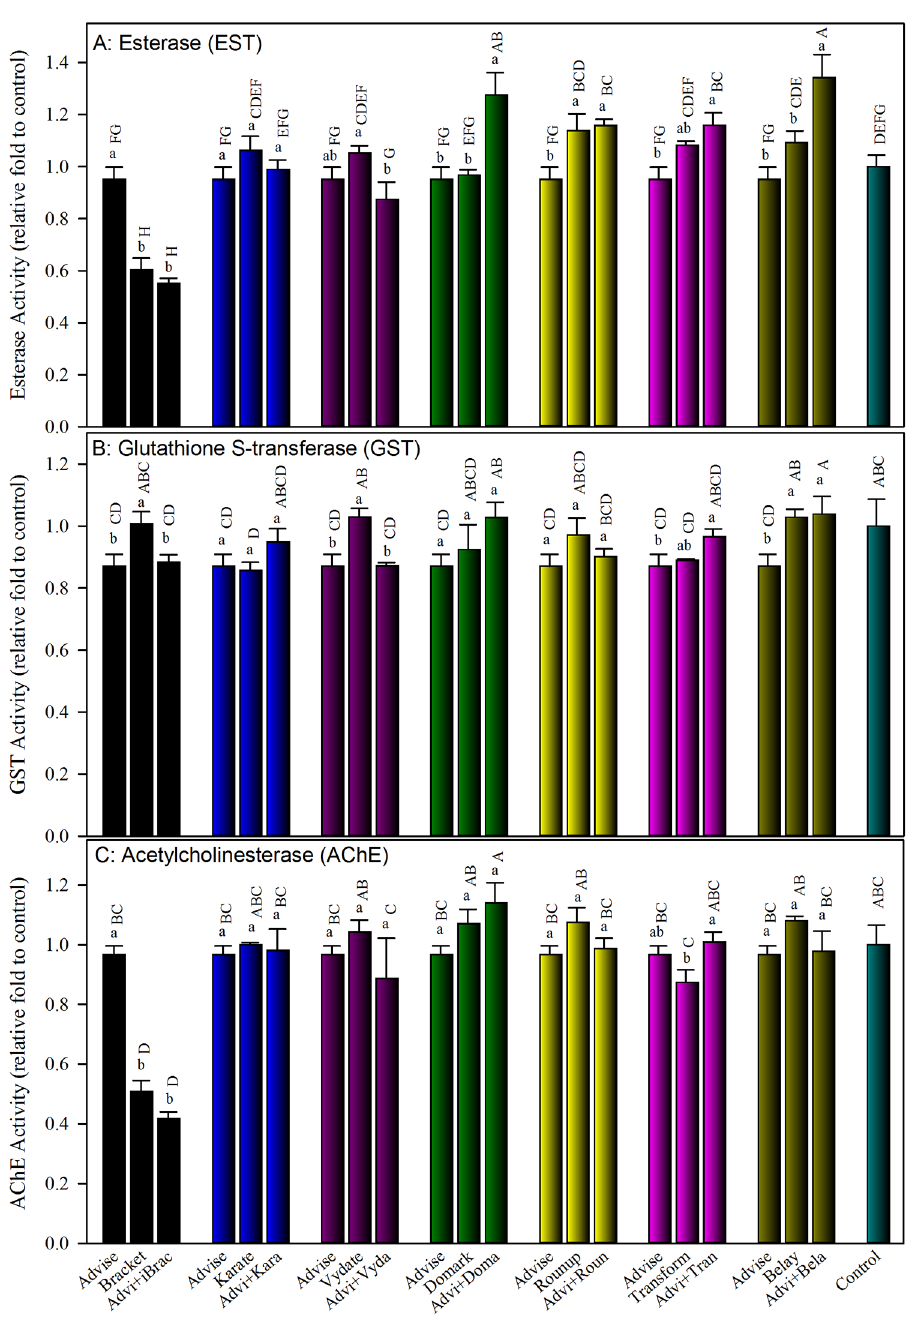
Fig 2. Impact of Advise and mixtures with seven representative pesticides on three insecticide- interacting enzymes,esterase(A), glutathione S-transferase (B), and acetylcholinesterase (C), activities in honey bee survivorsafter spray treatments. All concentrations used are listed in Table 1 as LC 20 determined in a previousstudy [30]. Advi, Brac, Kara, Vyda, Doma, Roun, Tran, and Bela were used as abbreviations for the same order of eight pesticideslisted in Table 1. Same letters abovethe error bars indicateno significantdifference:lower case letters are for within-groupcomparisons; capitalletters refer to comparisons among all treatments. The enzyme activity from Advise only was reused in each group for within-group comparisonand